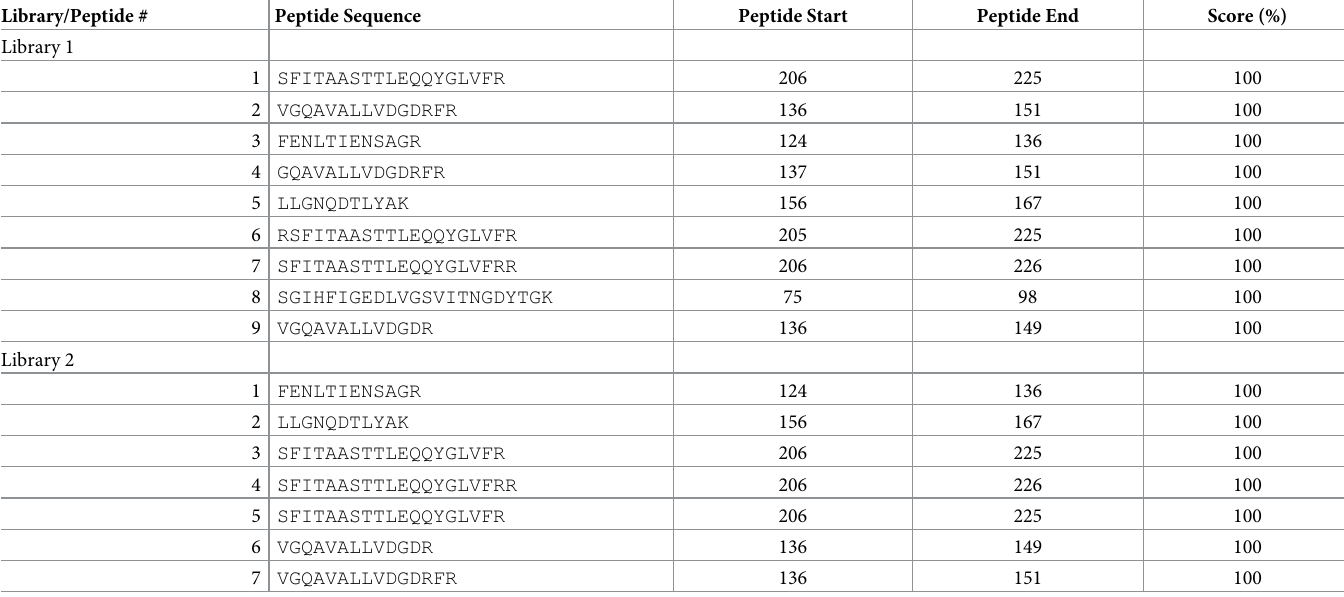
Table 2. List of Pp-PME peptides identified in the peptide datasets generated by UPLC-MS/MS from leaves expressing the PVX-Pp-PME construct. Library/Peptide # Peptide